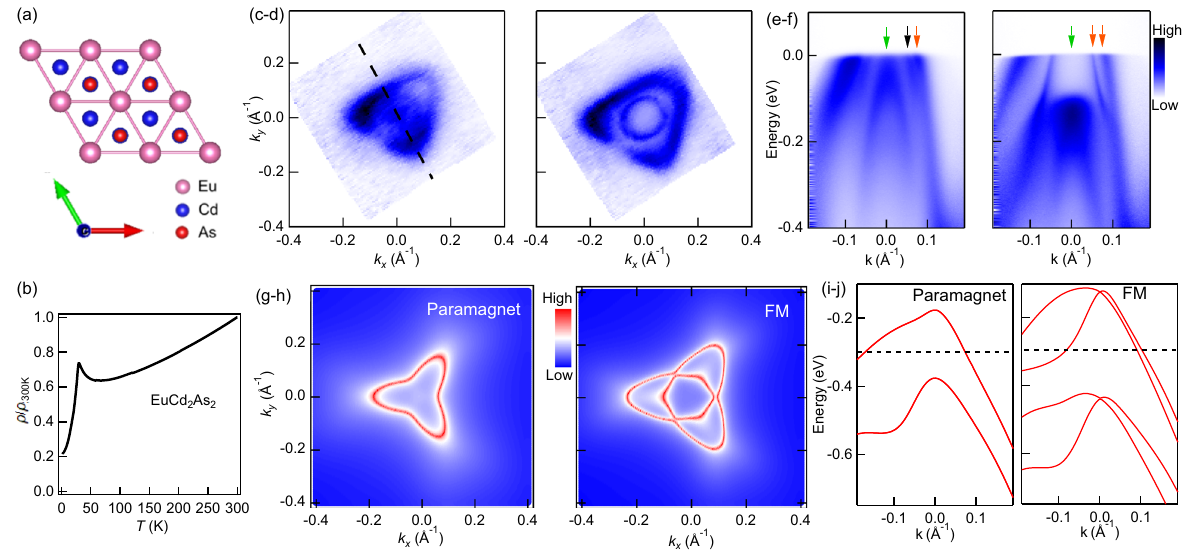
Fig. 1 Electronic structure and Fermi surface cuts of EuCd 2 As 2 from ARPES and DFT in para- and FM phase, crystal structure, and resistivity. a Crystal structure of EuCd 2 As 2 . b Temperature-dependent normalized resistivity, ρ ( T )/ ρ (300K), where ρ (300K) ≈ 4 × 10 − 4 ω cm. c , d FS results from ARPES measurements at 40 and 10 K, respectively, where T C = 26 K is FM transition temperature. e , f ARPES intensity along the black dashed lines in ( c , d ) measured at 40 and 10 K, respectively. The orange arrow points to the bands crossing the Fermi level; the green arrow points to the fully occupied hole band at the center; the black arrow points to a possible splitting of the bands at 40 K. The color scale shows relative photoelectron intensity in panels ( c – f ). g , h FS calculated using DFT in paramagnetic and FM states, respectively. Color scale shows probability of fi nding available electronic state. i , j Band dispersion from DFT calculations along the black dashed line in ( c ). Bands undergo approximately k -independent rigid (Zeeman) energy shifts in the FM phase.